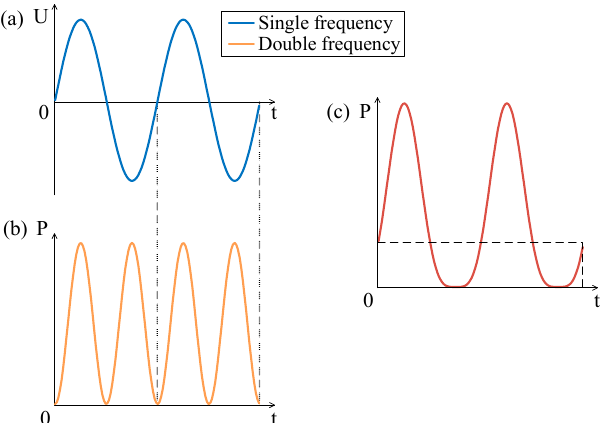
Figure 4. ( a ) AC excitation with amplitude of 5 V. Electric power with ( b ) AC = 5 V; ( c ) AC = 5 V and DC = 5 V.